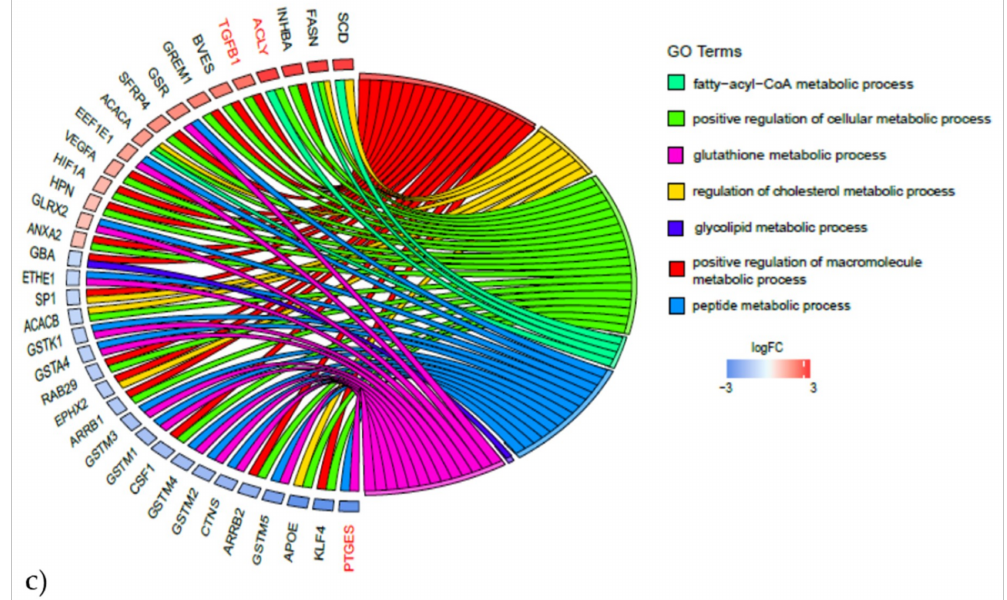
Figure 5. GOplot visualization of significantly regulated, metabolism-related GO terms and the corresponding di ff erentially expressed genes. A selection of the most significantly overrepresented GO terms is shown in a Bubble plot, whereby the z-score is assigned to the x-axis and negative log P value to the y-axis. The z-score is indicated by color intensity and the top GO IDs of the respective table are depicted in the plot ( a ). In the GO circle plot the inner ring represents a bar plot, where the bar height indicates the negative log P value of the GO term described. The color indicates the z-score and the outer ring shows scatterplots of the log fold change (logFc) of expression levels for genes within the GO term ( b ). Relationship between genes linked to preselected GO terms ( c ). The left section displays the di ff erentially expressed genes, which are associated with the specific metabolic processes, mapped to the right section. The color transition from blue to red indicates the log fold change of the expression levels of the control vs. TGF-ß1 exposed